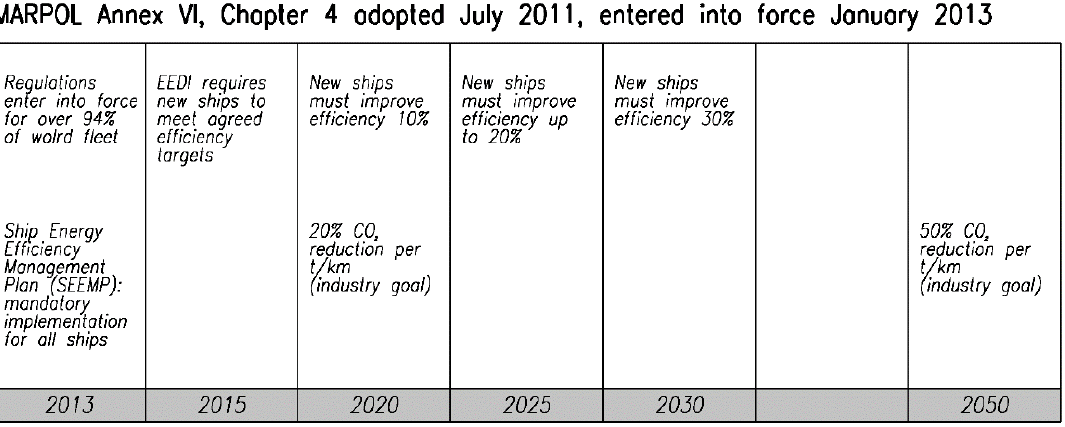
Figure 3. International Maritime Organization (IMO) roadmap for the reduction of ships’ environmental footprint.